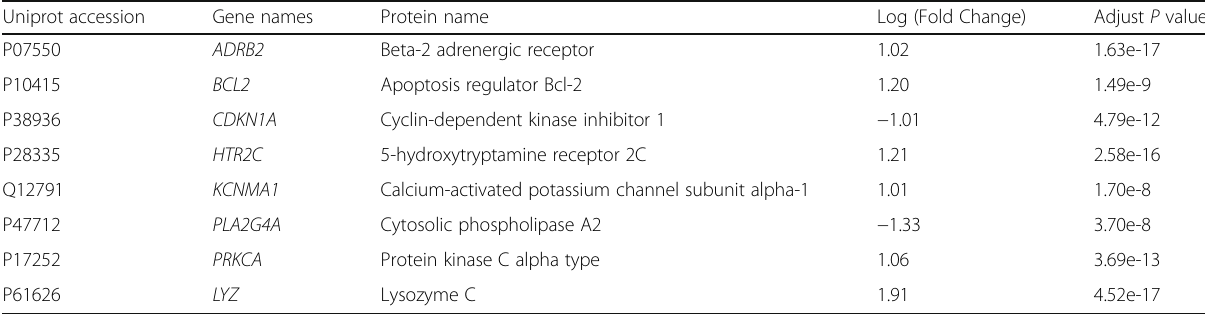
Table 2 Core targets of Fuzhengkangai Uniprot